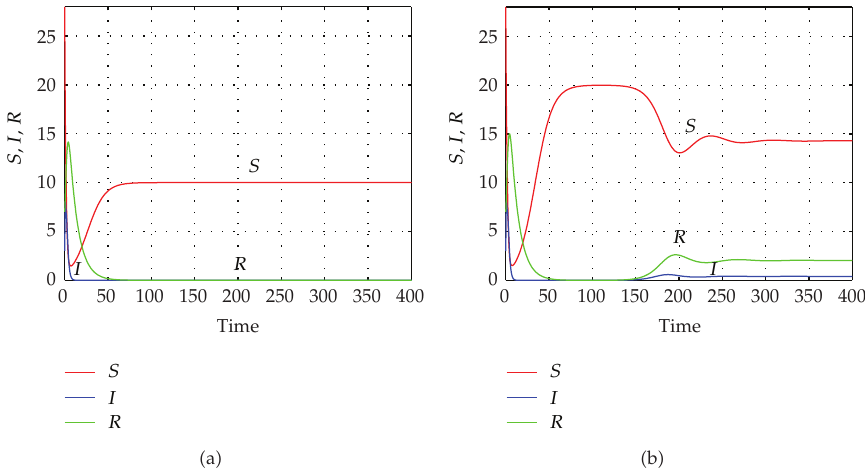
Figure 3: Solution of delayed SIR model (cid:3) 3.2 (cid:6) . We have asymptotically stable infection-free equilibrium when R 0 < 1 (cid:3) a (cid:6) , and small portion endemic equilibrium when 1 < R 0 < R c (cid:3) b (cid:6) , with τ (cid:7)